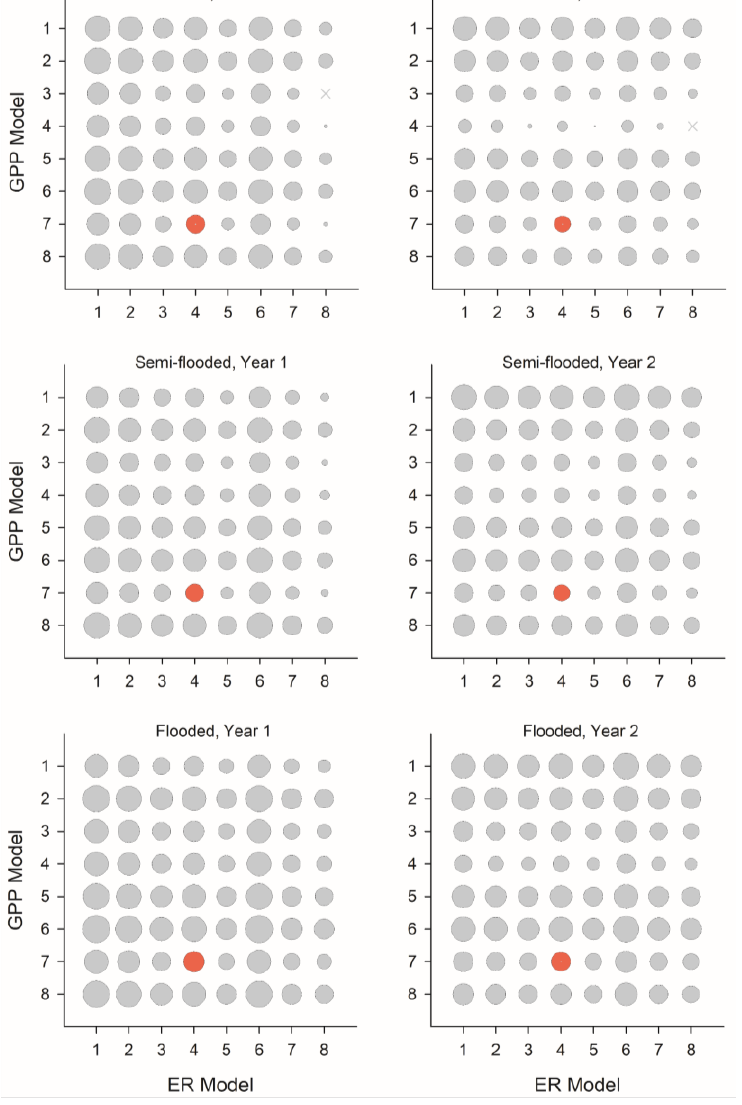
derived by combining the eight 2